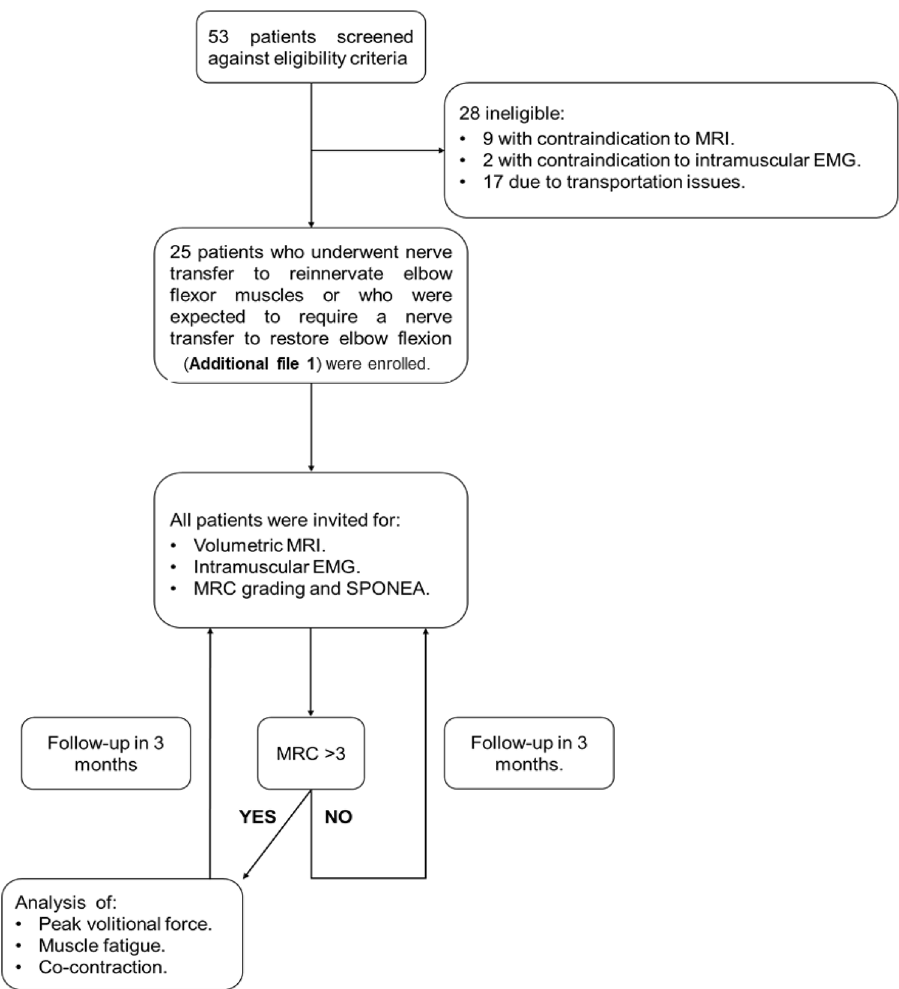
Figure 5. Study flow diagram. Flow diagram to illustrate study design and patient